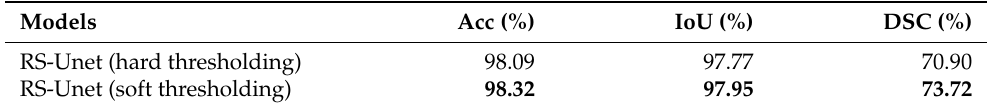
Table 2. Comparison of soft thresholding and hard thresholding in the model.